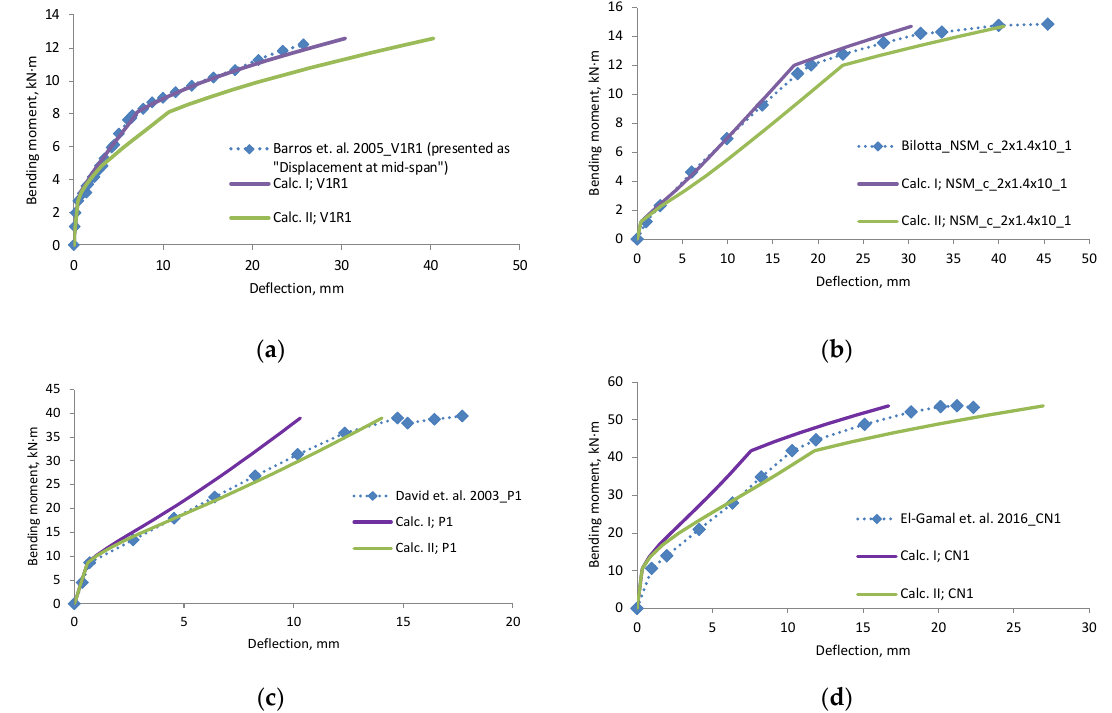
Figure 6. Bending moment–deflection curves, ( a ) beam V1R1; ( b ) beam NSM_c_2 × 1.4 × 10_1; ( c ) beam P1; ( d ) beam CN1.